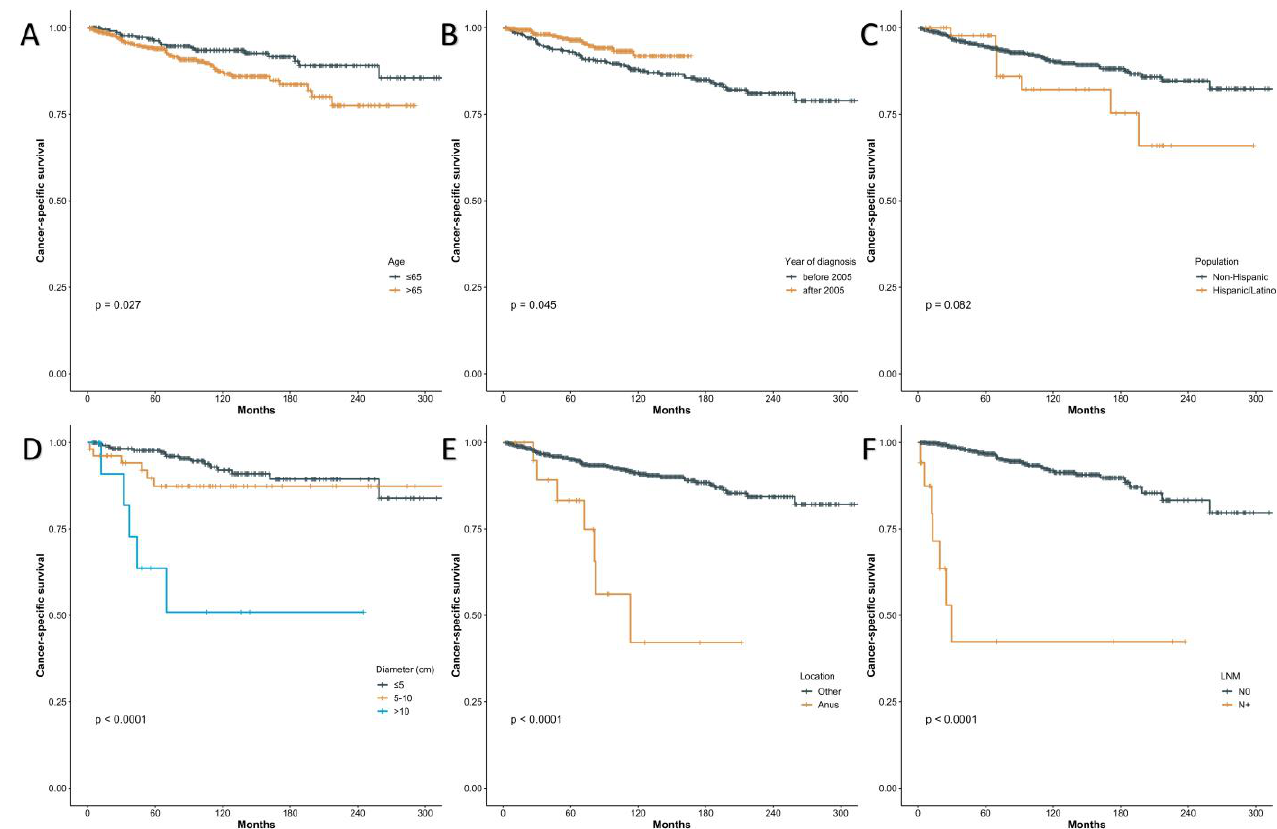
Figure 2. Kaplan – Meier curves of cancer-specific survival (CSS) using the SEER program data according to the age ( A ), year of diagnosis ( B ), population ( C ), diameter ( D ), location ( E ), the status of lymph nodes ( F ).